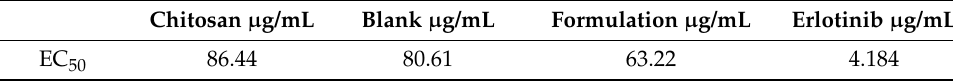
Figure 4. Cell viability against concentration of formulations. Table 9. EC 50 values.